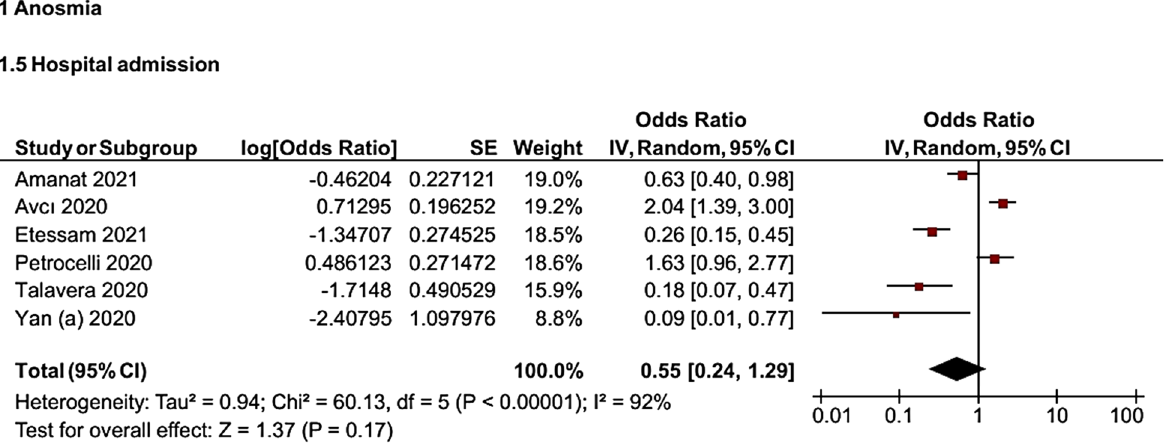
Fig. 5 Forest plot for the association of OD with hospital admission in